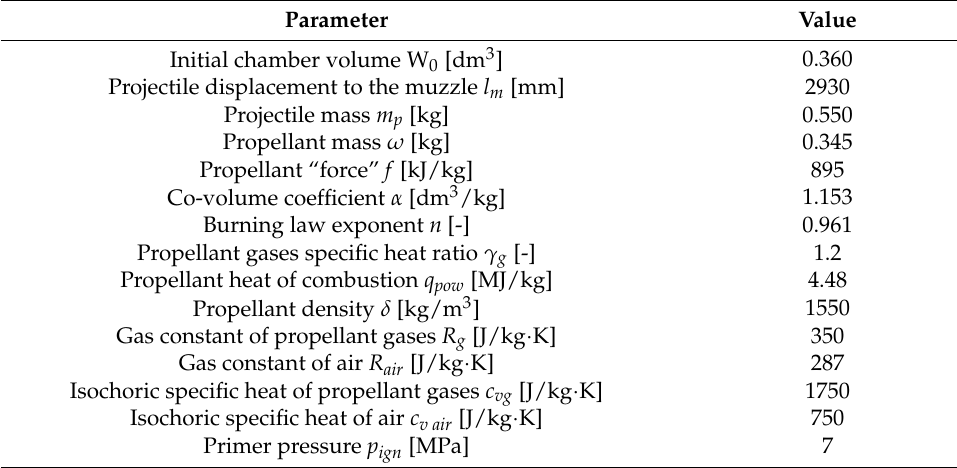
Table 9. Launching system parameters applied in